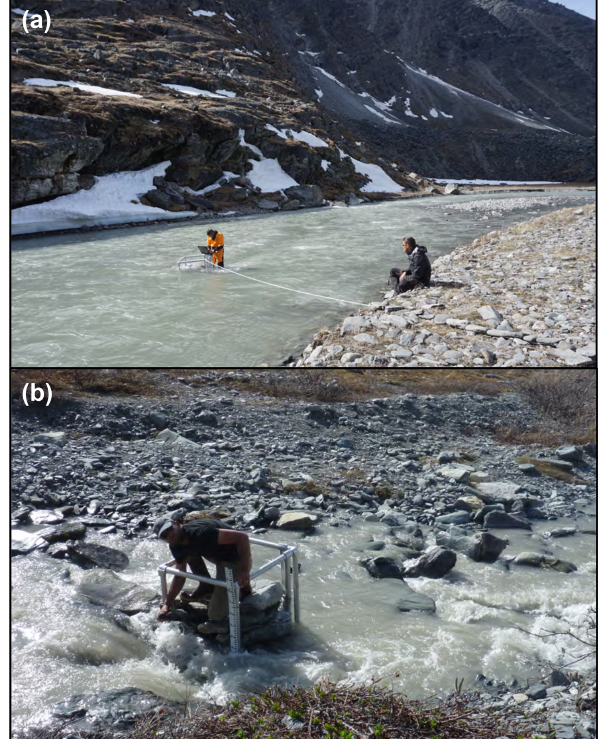
Figure 6. Stream stage gauges for (a) Carnivore and (b) Chamber- lin creeks. Instrumentation mounted in tubing is obscured by stage gauges.